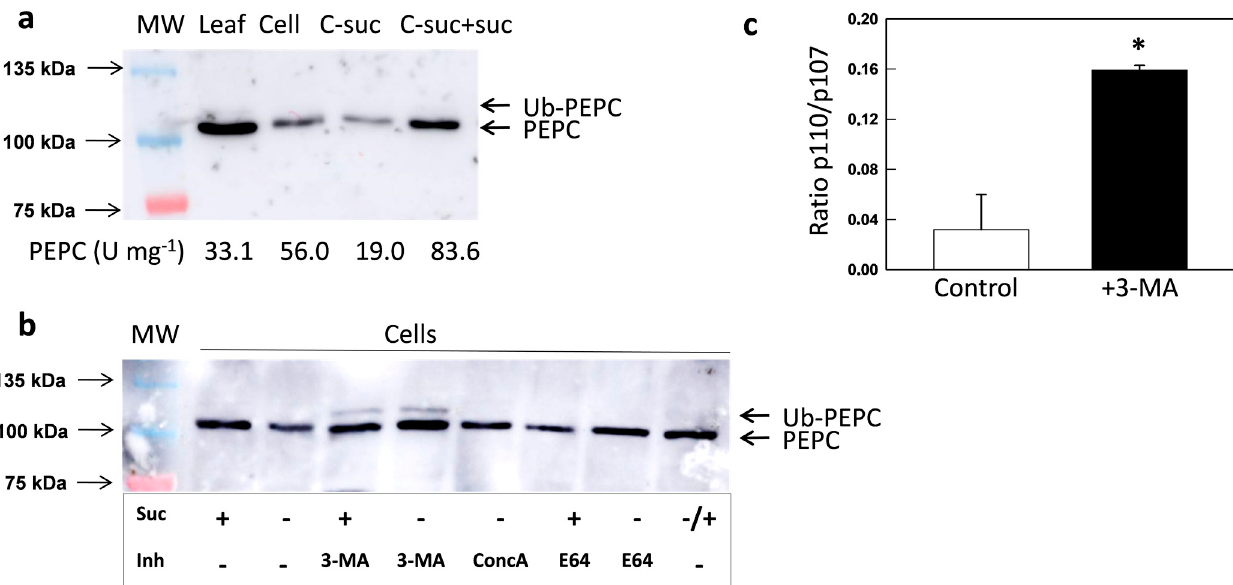
Figure 4. Effect of sucrose starvation and inhibitors on the PEPC of N. benthamiana culture cells. Crude extracts were prepared with leaves or cultured cells. Protein aliquots corresponding to 30 µg were analyzed by SDS-PAGE and immunoblotted with anti-PEPC antibodies. ( a ) When indicated, sucrose was suppressed from the culture medium of cells for 5 d (C-suc) or suppressed for 5 d and then resupplied for 2 d (C-suc+suc). The numbers under the immunoblots show the PEPC activities of extracts. ( b ) Cells were cultured with a control medium for 5 days. When indicated, sucrose was suppressed (5 d) or suppressed for 5 d and then resupplied for 2 d ( − /+). 3-MA was added at 2.5 mM (5 d), along with ConcA at 1 µM (16 h) and E64 at 10 µM (16 h). ( c ) The ratio of p110/p107 (Ub-PEPC/PEPC) of the signal with or without 3-MA was calculated. * p < 0.05 versus Col-0 ( t -test, n = 3).